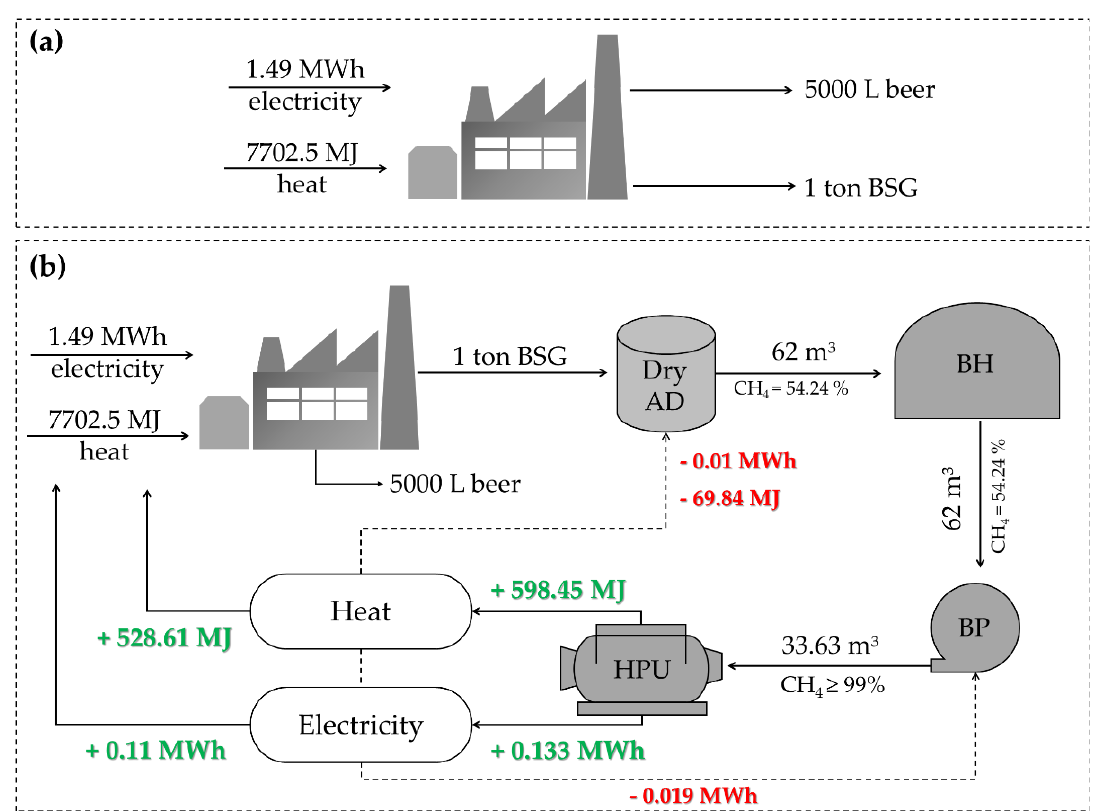
Figure 4. Industrial mass and energy balance for bioenergy recovery from dry AD of BSG. ( a ) Demand of electricity and heat for beer production; ( b ) recovery of bioenergy with dry AD of BSG. Label: AD, anaerobic digester; BH, biogas holder; BP, biogas purificator; HPU, heat and power unit. Adapted from Sganzerla et al. [29], with permission from Springer Nature.